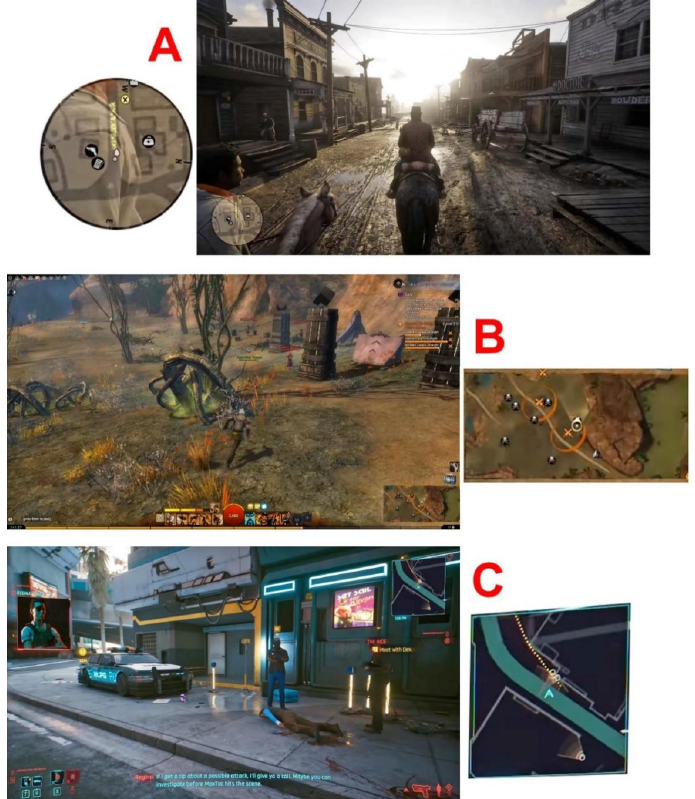
Figure 1. Examples of video games with a mini-map in the game cartography interface ( A ) Red Dead Redemption 2; ( B ) Guild Wars 2; ( C ) Cyberpunk 2077.